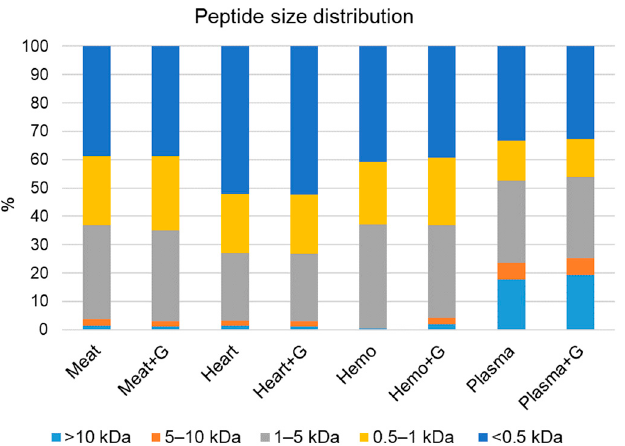
Figure 3. Peptide size distribution of native and glycated hydrolysates.